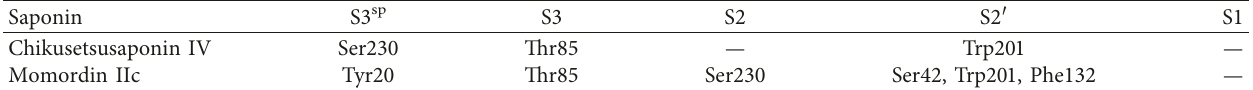
Table 2: Residues of amino acids with hydrogen bonding in the active pockets. Saponin